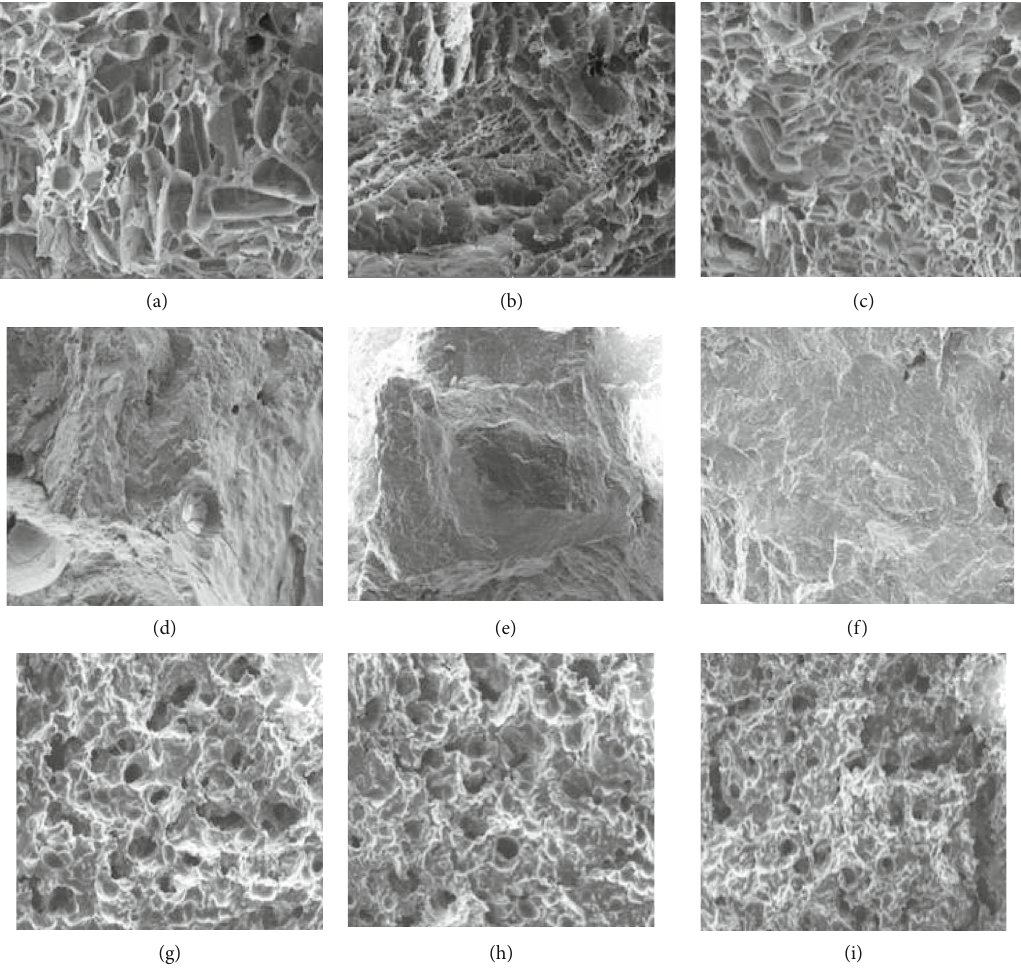
Figure 3: Microstructure of the aged starch gels containing 0%HDP (a, d, g), 25%HDP (b, e, h), and 50%HDP (c, f, i). The gels were prepared in water (a – c), 45 ° Bx sucrose solution (d – f), or coconut milk (g – i) and kept at 4 ° C for 21